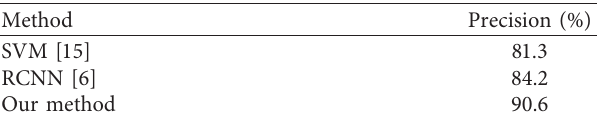
Table 3: Precision of classification of intensity levels for happy